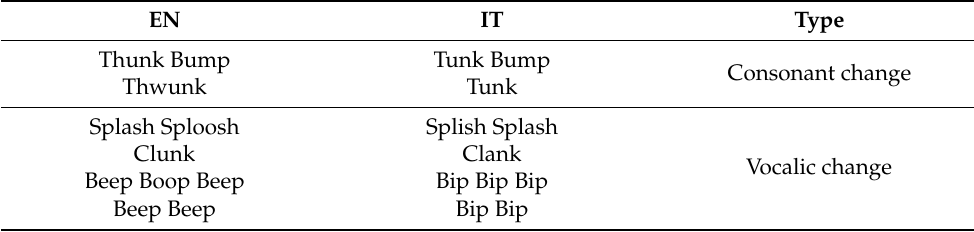
Table 2. List of ‘addition’ instances.